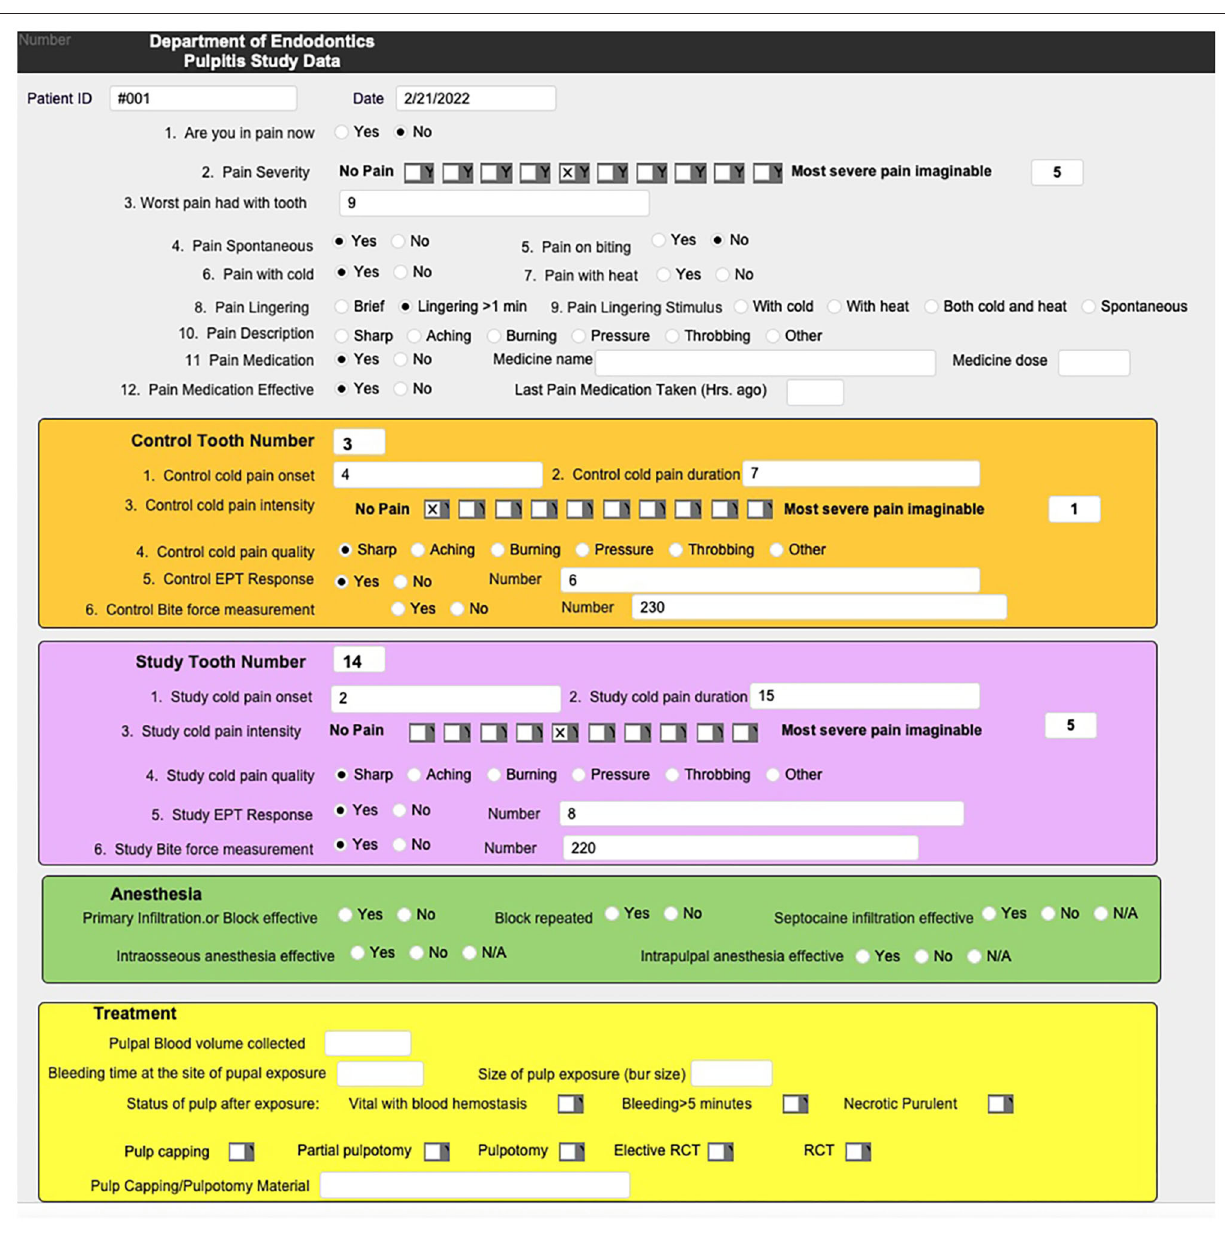
(BD Biosciences, San Jose, CA) containing 2 ml PBS